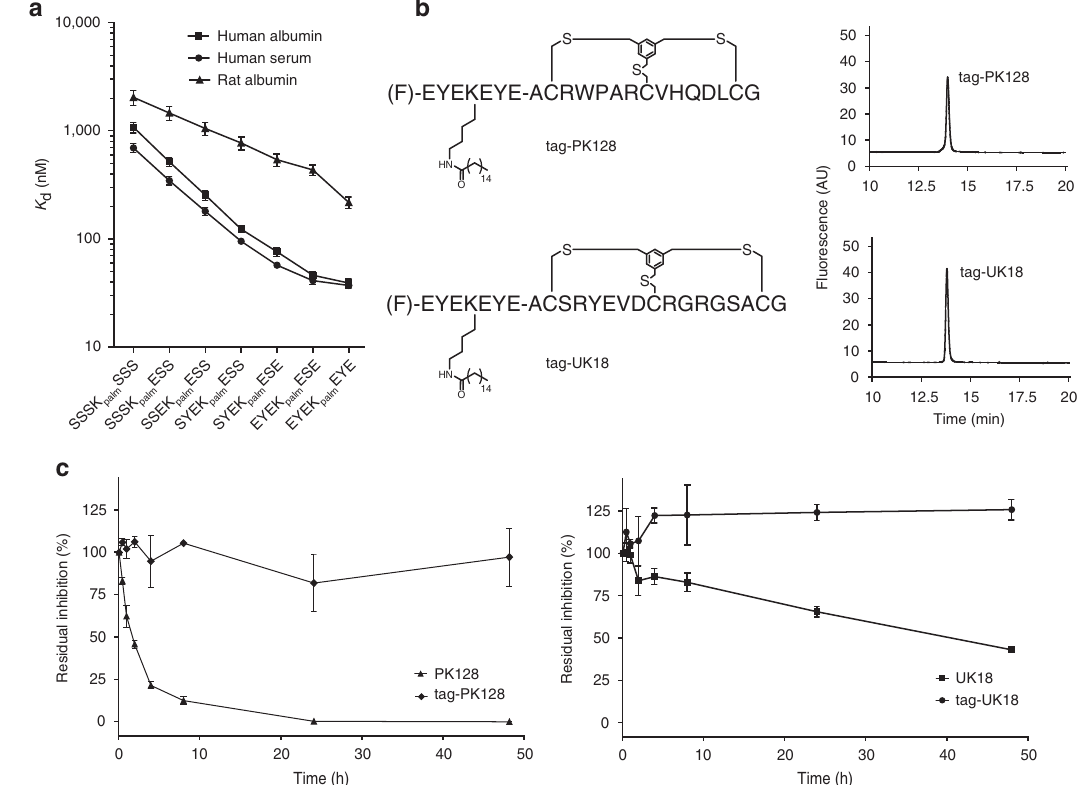
Figure 3 | Application of evolved tag to bioactive peptides. ( a ) Binding of peptides from different evolution cycles to human and rat albumin. Average values and s.d.’s of three measurements are shown. ( b ) Structures of tag-PK128 and tag-UK18 and their purity after automated synthesis and a single HPLC purification. ( c ) Stability of tagged and non-tagged bicyclic peptide PK128 and UK18 in human plasma at 37 (cid:2) C. Residual inhibition activities were quantified in protease activity assays using fluorogenic substrates of plasma kallikrein and urokinase. Average values and s.d.’s of three measurements are shown.